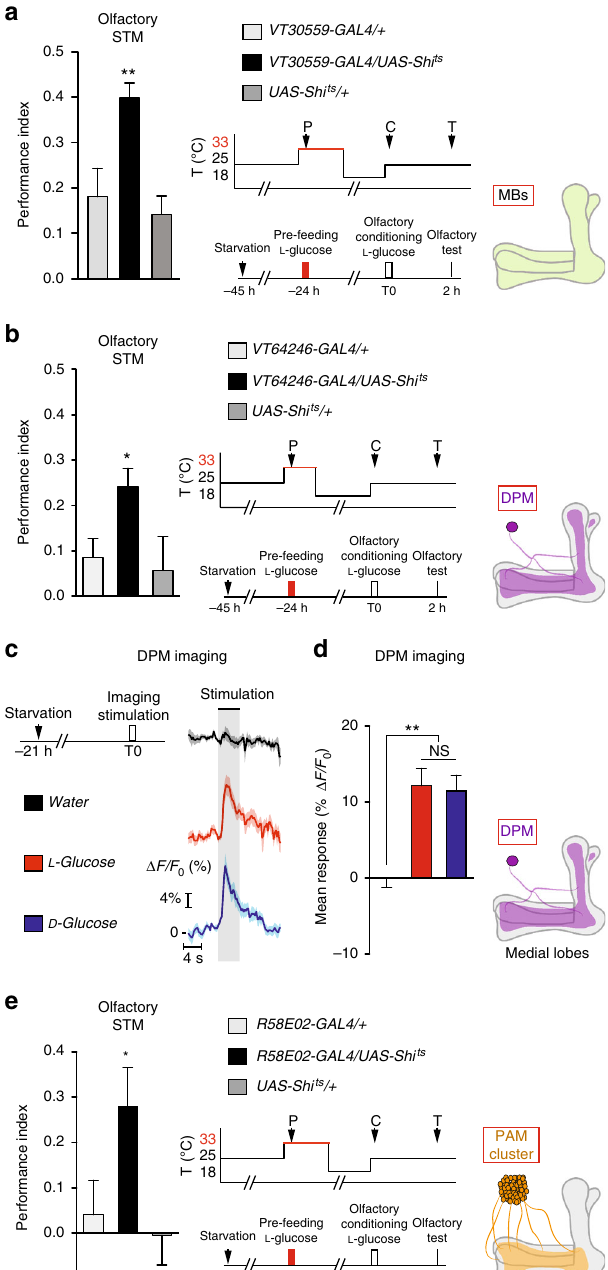
Fig. 3 CFM formation requires synaptic activity in DPM neurons, the MB and PAM neurons. a Blocking MB neurons under VT30559-GAL4 control 30 min before, during, and until 2.5 h after L -glucose pre-feeding abolishes the sugar devaluation ( F (2,42) = 8.966; p < 0.001; n ≥ 14). b Blocking DPM neurons under VT64246-GAL4 control 30 min before, during and until 1.5 h after L -glucose pre-feeding abolishes the sugar devaluation ( F (2,44) = 3.868; p = 0.028; n ≥ 14). c , d DPM neurons respond selectively to sweet stimulation. c Left: imaging protocols; right: time course of response. n ≥ 14. Black bar: stimulus presentation. d Average response to L -glucose, D - glucose and water. DPM neurons responded signi fi cantly to L - and D - glucose ( t -test, t 12 = 5.290; p < 0.001; for L -glucose and t -test, t 18 = 5.450; p < 0.001 for D -glucose; n ≥ 134) at signi fi cantly higher levels than water ( F (2,42) = 9.090; p < 0.001; n ≥ 11; p = 0.966 in post hoc comparison between the responses to D - and L -glucose). e Blocking PAM neurons under R58E02-GAL4 control 30 min before, during and until 1.5 h after L -glucose pre-feeding abolishes the sugar devaluation ( F (2,25) = 4.066; p = 0.03; n ≥ 9). See also Supplementary Figs. 3, 4. Means are ± SEM; statistical tests: t - test and one-way ANOVA; NS: p ≥ 0.05; * p < 0.05; ** p < 0.01